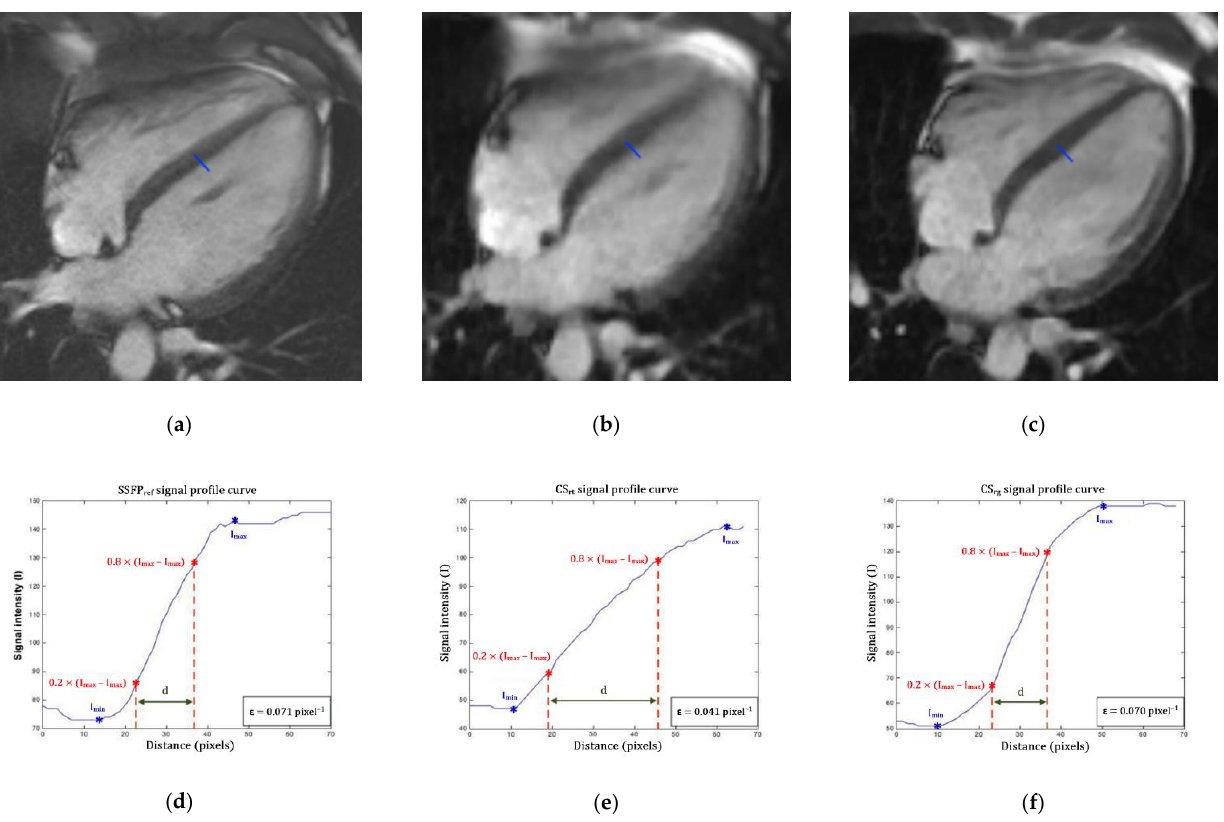
Figure 1. Edge sharpness measurement. An orthogonal profile line is drawn across the border between the interventricular myocardium and the left ventricular blood pool (blue line) on a 4-chamber view at end-diastole provided by ( a ) the reference segmented SSFP sequence, ( b ) the real-time compressed sensing sequence and ( c ) the retrogated compressed sensing prototype, providing intensity profiles (blue curves) along the line for ( d ) reference, ( e ) real-time and ( f ) prototype sequences. The edge sharpness was calculated as the inverse of the distance d (in pixels) from the positions corresponding to 20% and 80% (red stars) of the difference between the maximum and minimum signal intensities (black crosses) along the profile line and was expressed in pixel − 1 . Abbreviations: SSFP ref , reference steady-state free precession; CS rt , real-time compressed sensing; CS rg , retrogated compressed sensing; ε , edge sharpness; Ymax, maximum signal intensity; Ymin, minimum signal intensity; d, distance along the intensity